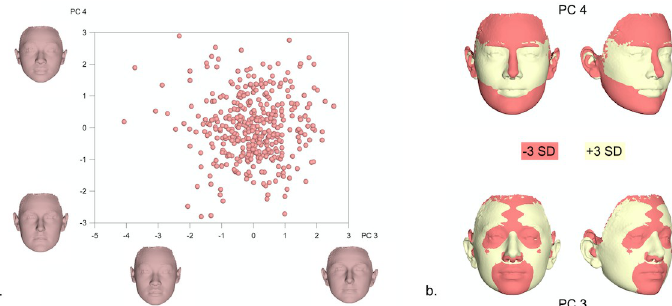
Fig 4. a. PCA graph displaying facial shape variation in females (in SD units), as explained by PC3 (9.1%) and PC4 (7.2%). The corresponding 3D facial morphings show the shape extremes from -3 to +3 standard deviations of PC scores within each axis. b. Best fit superimpositions of shape transformations created from the Procrustes coordinates corresponding to -3SD and +3SD of PC scores within each axis from the average shape configuration in the female population. The superimpositions display the direction of shape variation explained by each PC.